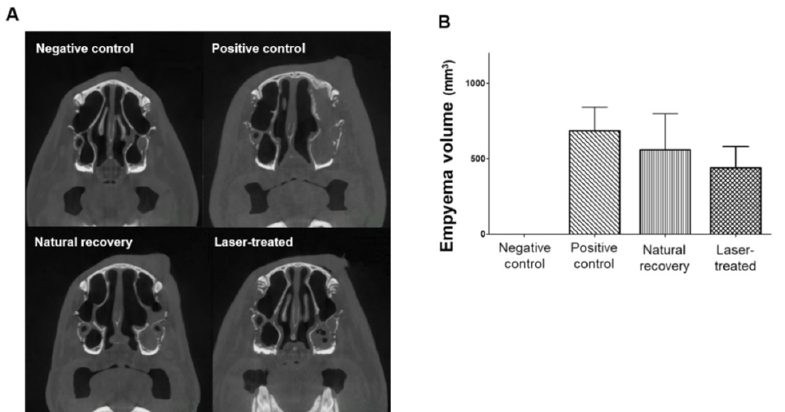
Figure 1. Representative images of and quantitative data for empyema volumes, estimated using computed tomography. ( A ) The negative control group showed no empyema in the maxillary sinus, whereas the positive control group showed total soft tissue density in the left maxillary sinus. ( B ) In the laser-treated group, empyema volumes were decreased compared with those in the natural recovery group. Data are expressed as the means ± SEMs. The results were statistically analyzed by Student’s t -tests.